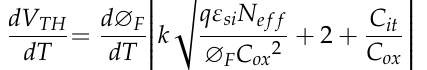
Figure 4. ( a ) V TH as a function of temperature for GAA NW-FET and FinFET from Figure 3. Similar temperature sensitivities of V TH are observed for both GAA NW-FET and FinFET. ( b ) Subthreshold swing ( SS ) as a function of temperature also shows same slopes for both GAA NW-FET and FinFET. The V TH as a function of temperature can be explained by the following equation [13]: